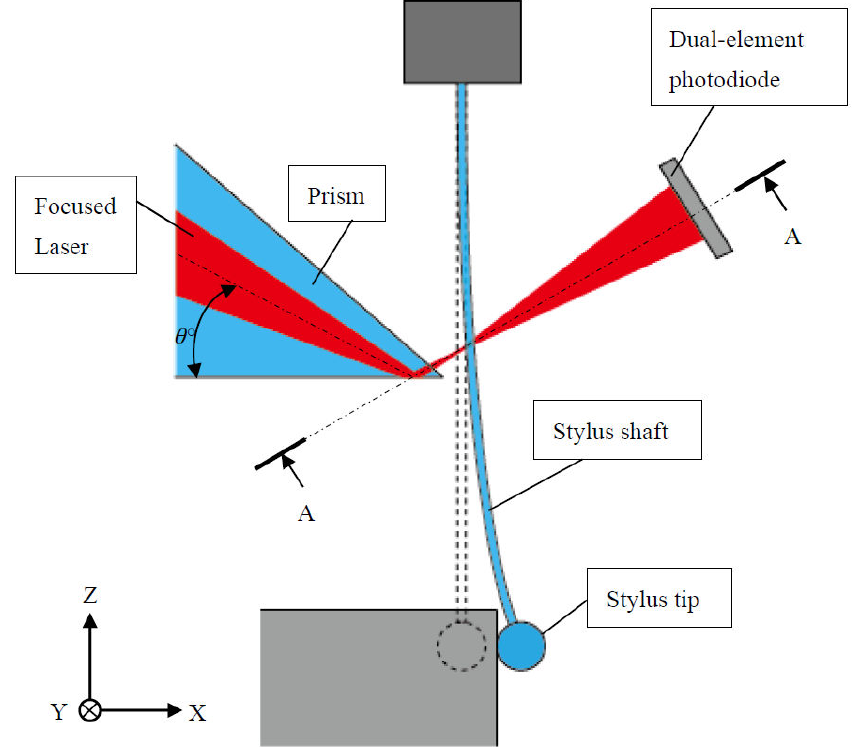
Figure 1. Optical system of the fiber